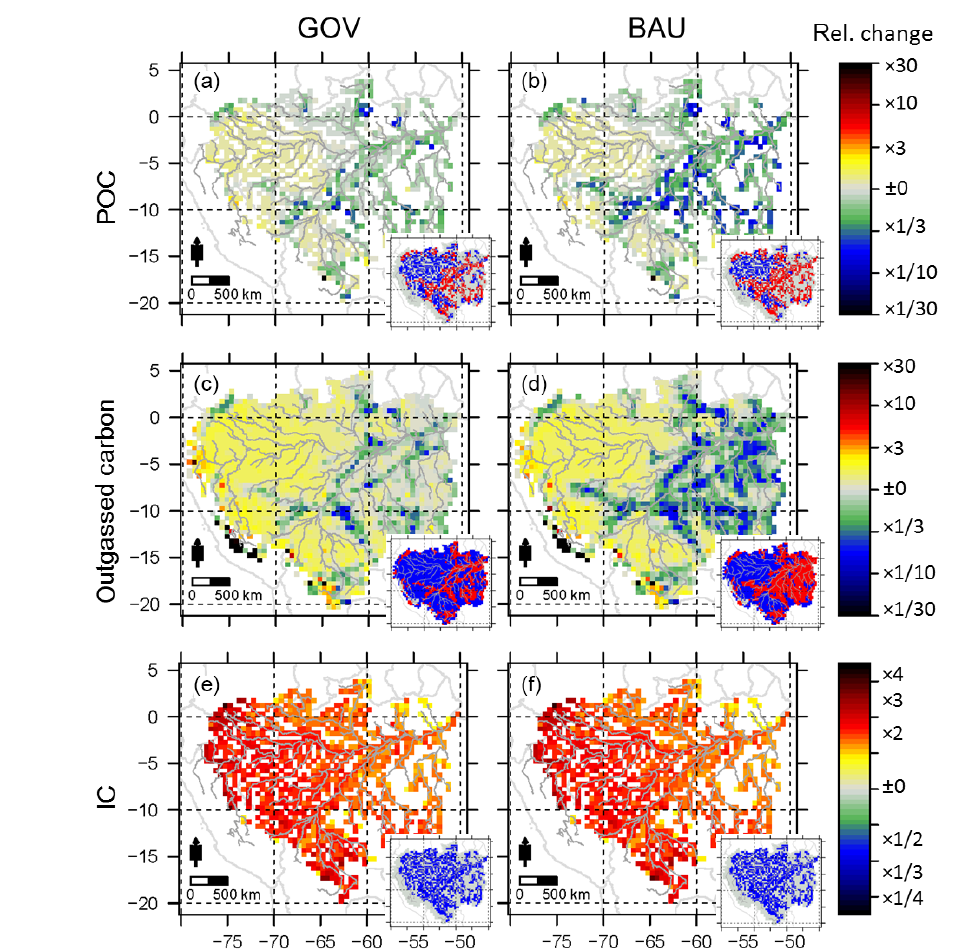
Figure 5. Change in carbon caused by deforestation and climate change. Climate model mean ( E CCDefor ) of the change of particulate organic carbon POC (a, b) , outgassed carbon (c, d) and inorganic carbon IC (e, f) . The inset maps show blue areas where changes are predominantly caused by climate change ( D CC ) and red areas where changes are predominantly caused by deforestation ( D Defor ). For further details see Fig. 3. White areas within the Amazon basin represent cells where changes are not significant ( p value >